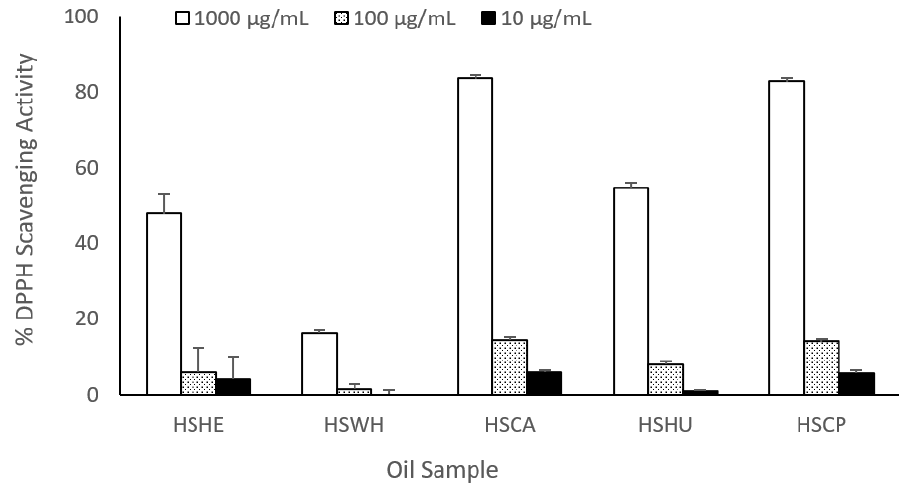
Figure 4. DPPH radical scavenging capacities of oil extracted from hemp hearts (HSHE), hemp whole seeds (HSWH), hemp cake (HSCA), hemp seed hulls (HSHU) and cold-pressed hemp oil (HSCP).